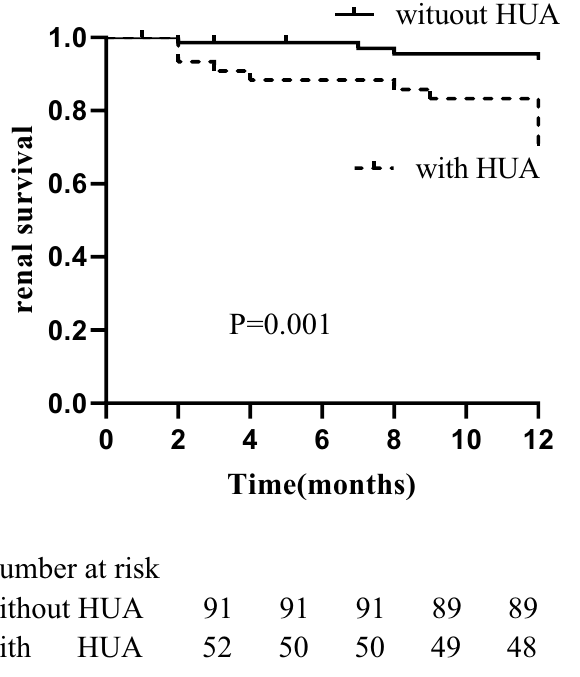
Figure 3. Kaplan–Meier renal survival for ANCA-related renal vasculitis patients.